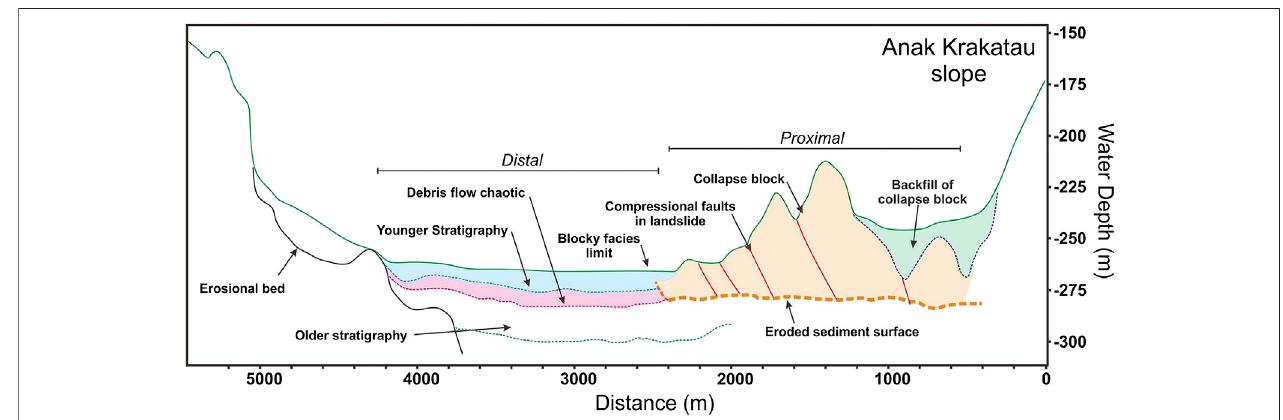
FIGURE8| Interpretations model ofseismic Pro fi le SKC-03distance vs. depth (m) showsthe collapse blocks and eroded sediment layersduring 22nd December 2018 Anak Krakatau Event (The depth conversion using constant velocity of 1760 km/s).